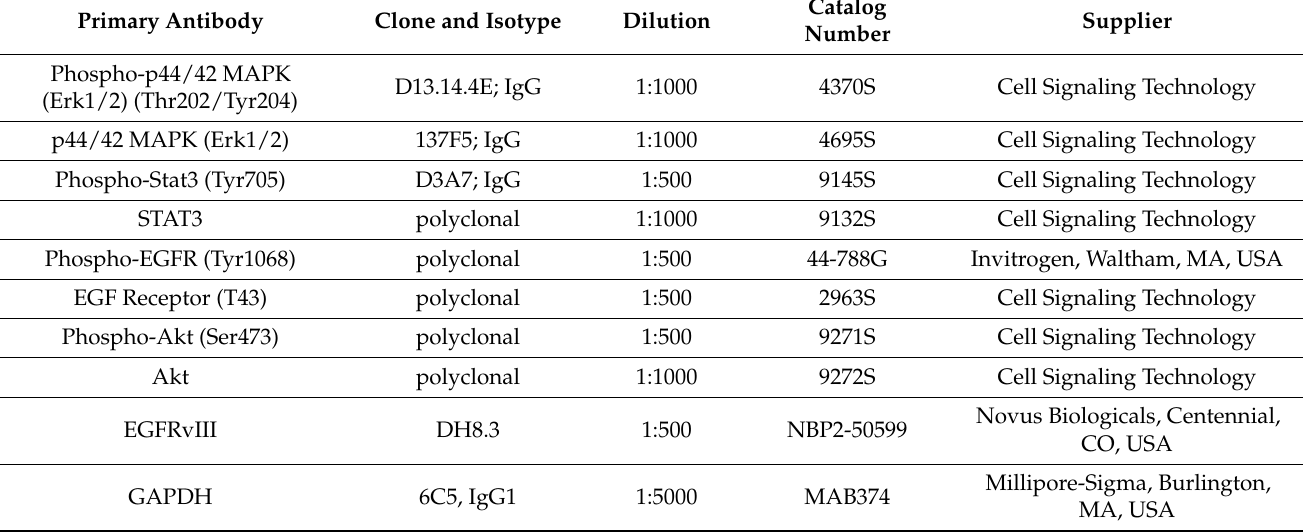
Table 1. Antibodies used for Western blot and immunohistochemical